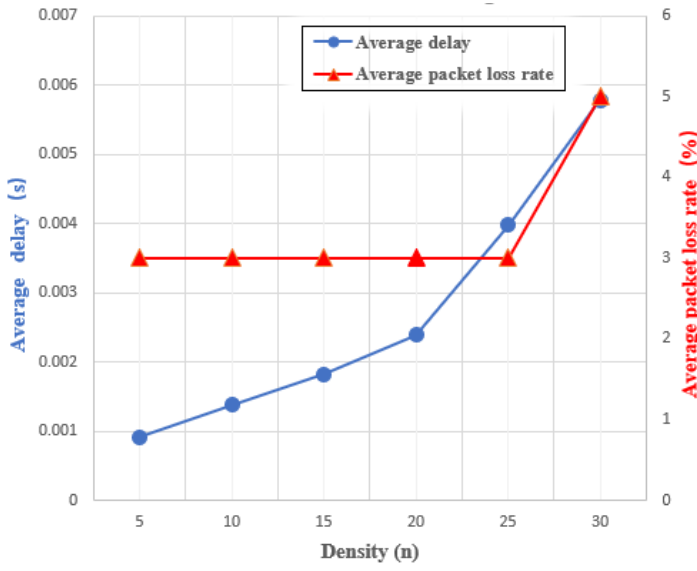
Figure 8. The impact of density in delay and packet loss